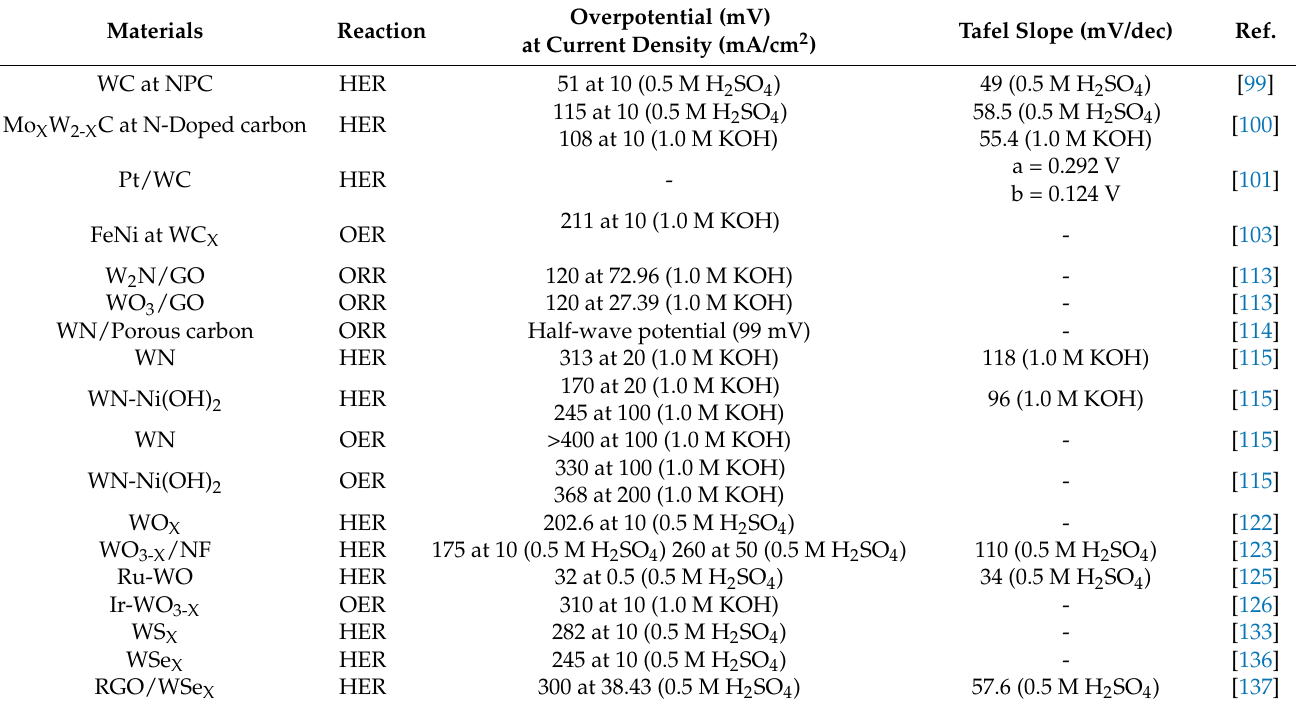
Table 4. Electrochemical parameters of tungsten-based compound nanocatalysts currently